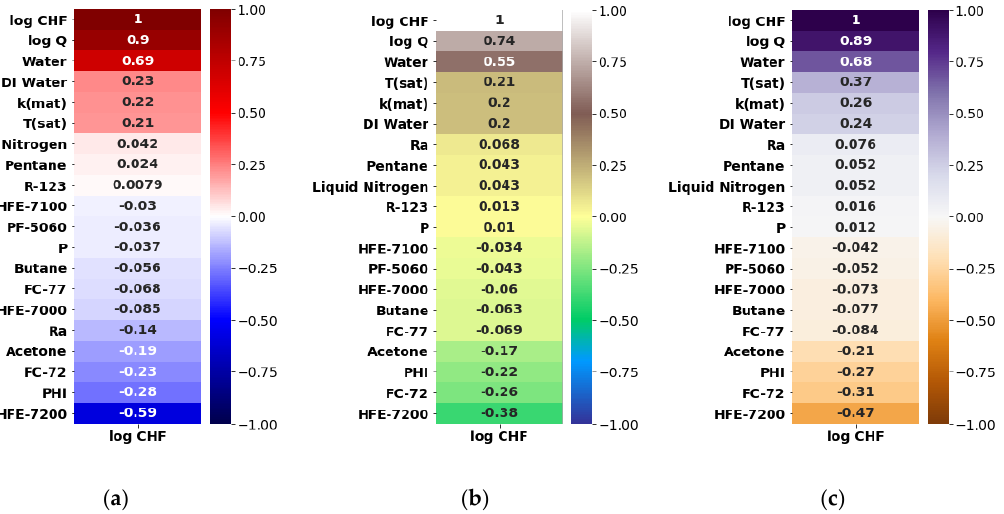
Figure 3. Visualizing the experimental CHF data in terms of the surface inclination, liquid saturation temperature, pressure, surface roughness, and material conductivity.